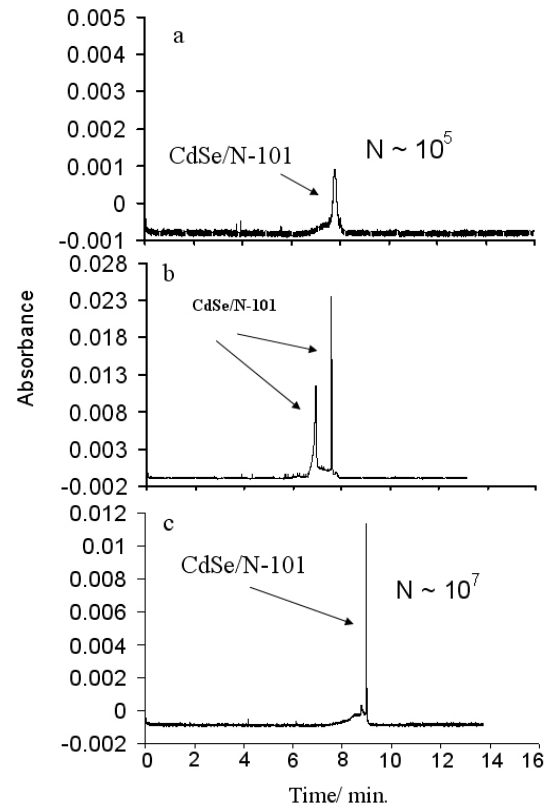
Figure 5. CdSe/N-101 QDs MEKC. (a) 0.5% N-101 (only MEKC peak); (b) 3% N-101 (both MEKC and focused peaks); and (c) 1.5% N-101 (focused peak). Separation conditions: electrolyte buffer 50 mM SDS containing 10 mM sodium tetraborate, applied voltage +20 kV (measured current 40 µA), detection λ = 330 nm. Sample injection: 50 mbar/0.3 min. CdSe/N-101 QDs size, 3.4 nm.